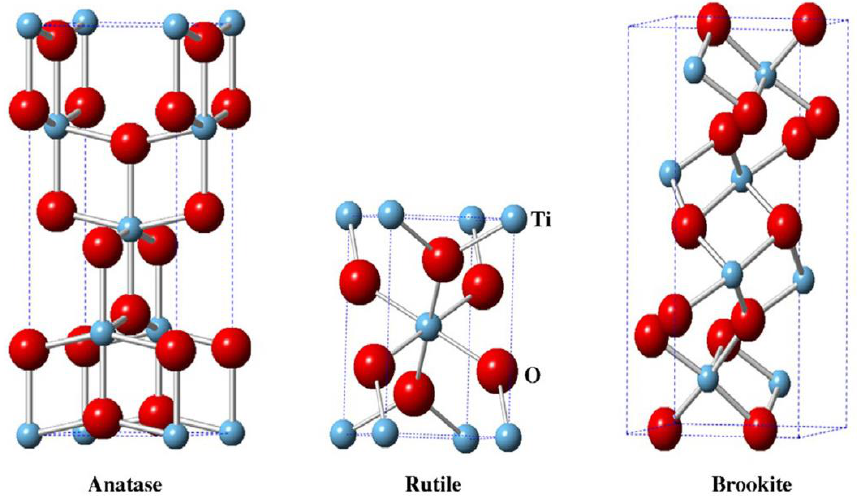
Figure 1. Crystal structures of brookite, rutile, and anatase TiO 2 . Reprinted with permission from Ref. [46]. Copyright 2015, Elsevier.